Question: Sum up the contents of this chart in one sentence.
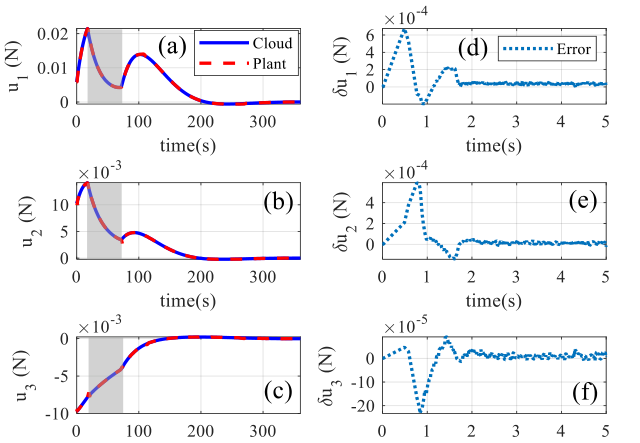
Answer: Comparative analysis and error convergence in satellite